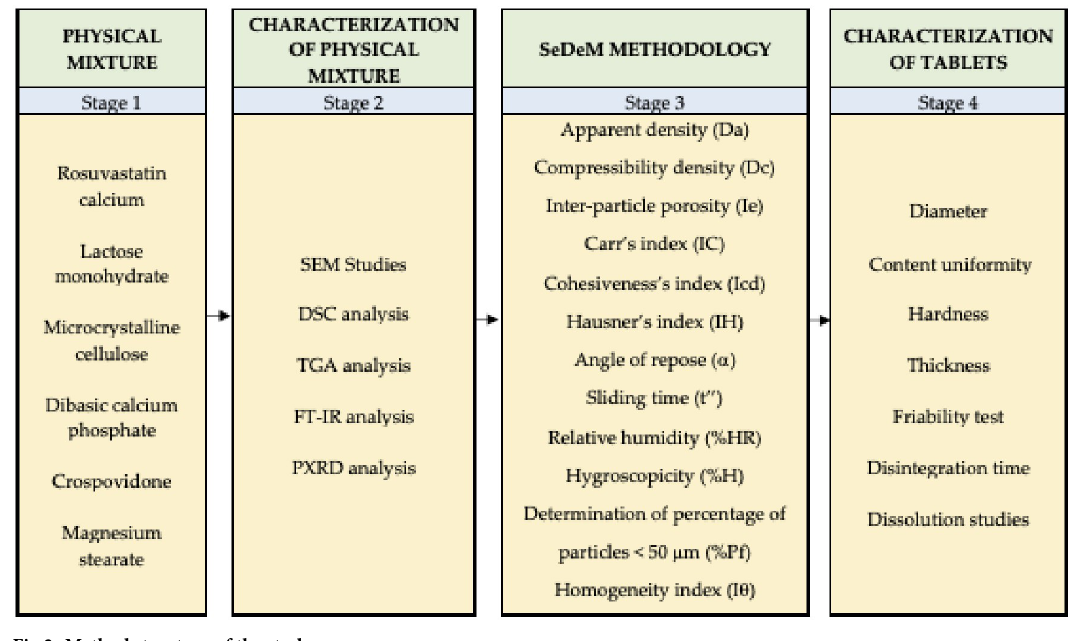
Fig 2. Method structure of the